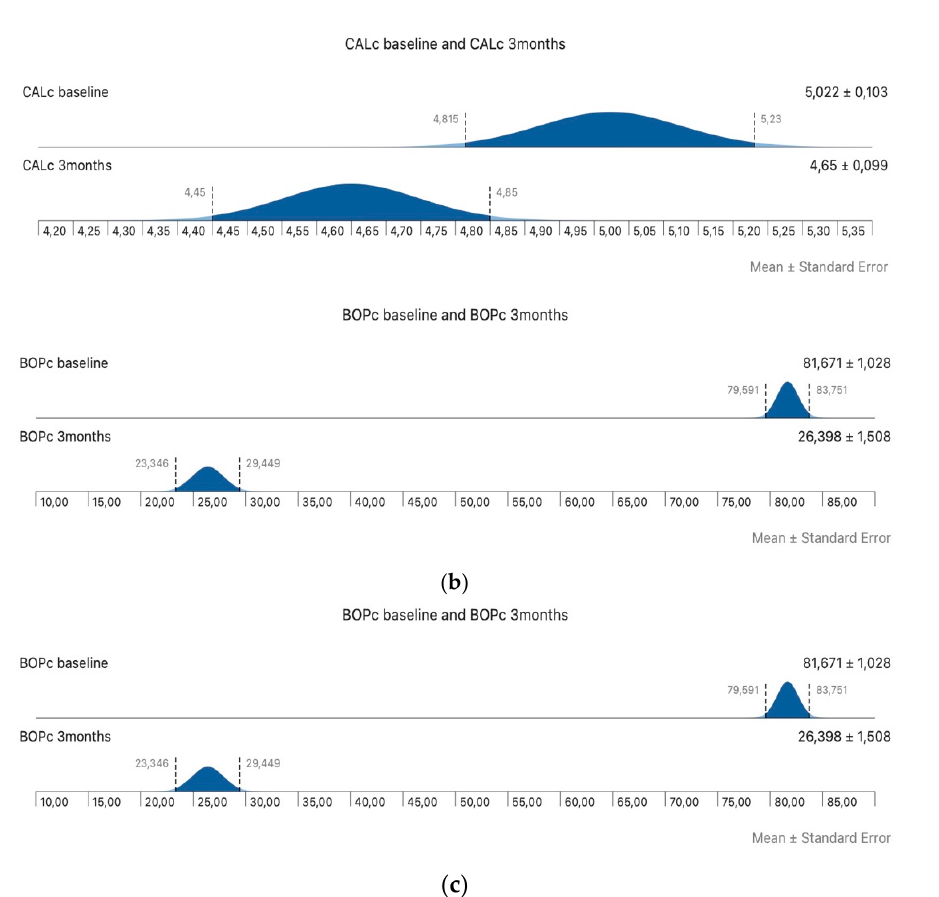
Figure 2. Comparaison at baseline and 3 months in control group between ( a ) probing depth values (PDc: probing depth in SRP alone sites); ( b ) clinical attachment loss (CALc: clinical attachment loss in SRP alone sites); ( c ) bleeding on probing values (expressed in %) (BOPc: bleeding on probing in SRP alone sites).